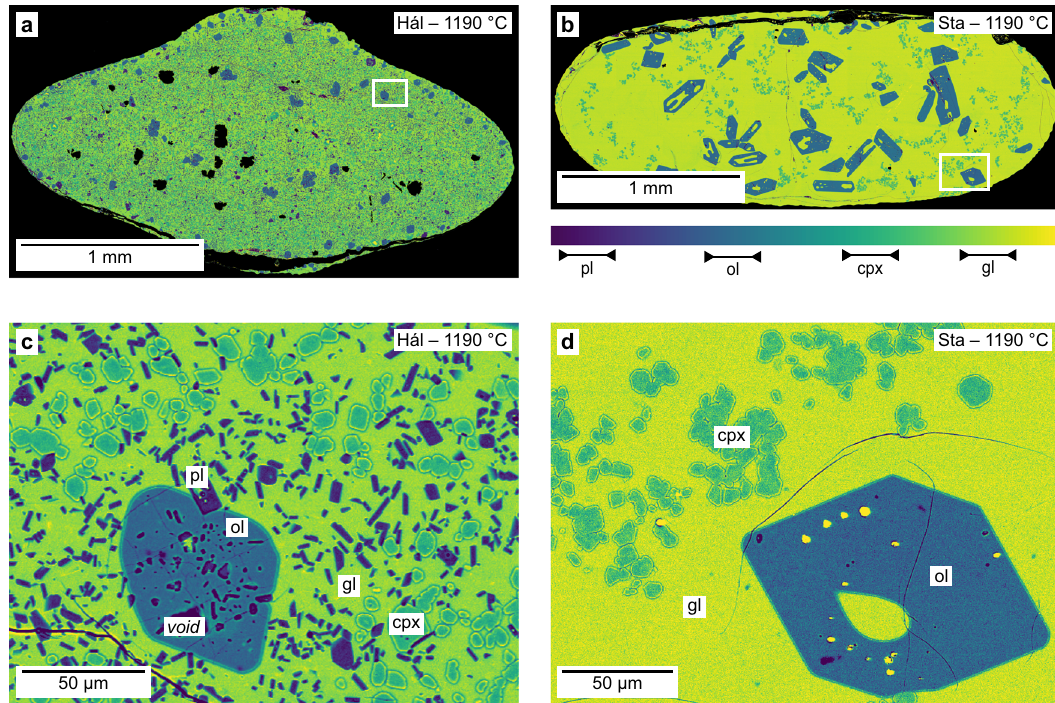
Fig. 2 False-colour backscattered electron (BSE) images of the products of synthesis experiments. Synthesis experiments on Háleyjabunga (Hál) and Stapafell (Sta) lava analogues were both performed at 300 MPa and 1190 °C. These conditions were chosen to maximise differences in equilibrium phase equilibria 7 . a Products of the synthesis experiment on the incompatible element-depleted Háleyjabunga lava analogue contain relatively modest amounts of glass [gl, yellow-green; melt mass fraction ( F ) ~ 0.72]. Black areas within the products are voids and cracks generated during polishing. b Products of the synthesis experiment on the incompatible element-enriched Stapafell lava analogue contain relatively large amounts of glass (gl; F ~ 0.90). c , d High- resolution images of ( a ) and ( b ) showing crystals of olivine (ol, blue), clinopyroxene (cpx, blue-green) and plagioclase (pl, purple) in the products of the experiment on the Háleyjabunga analogue ( c ), and olivine and clinopyroxene crystals in the products of the experiments of the Stapafell analogue ( d